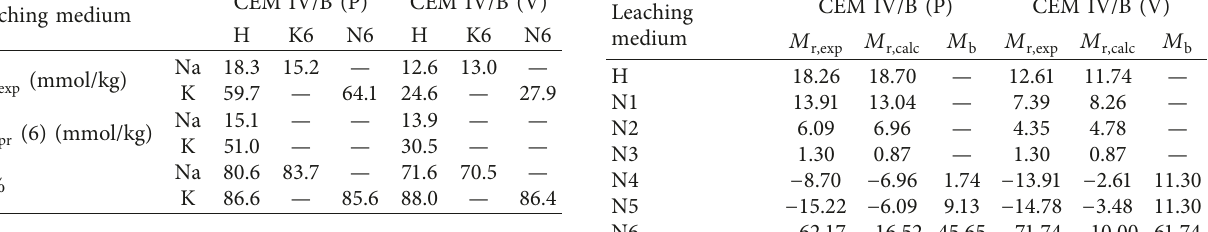
Table 6: Predicted and experimental M capabilities of Na + and K + ions by hydrated cement pastes. Leaching medium